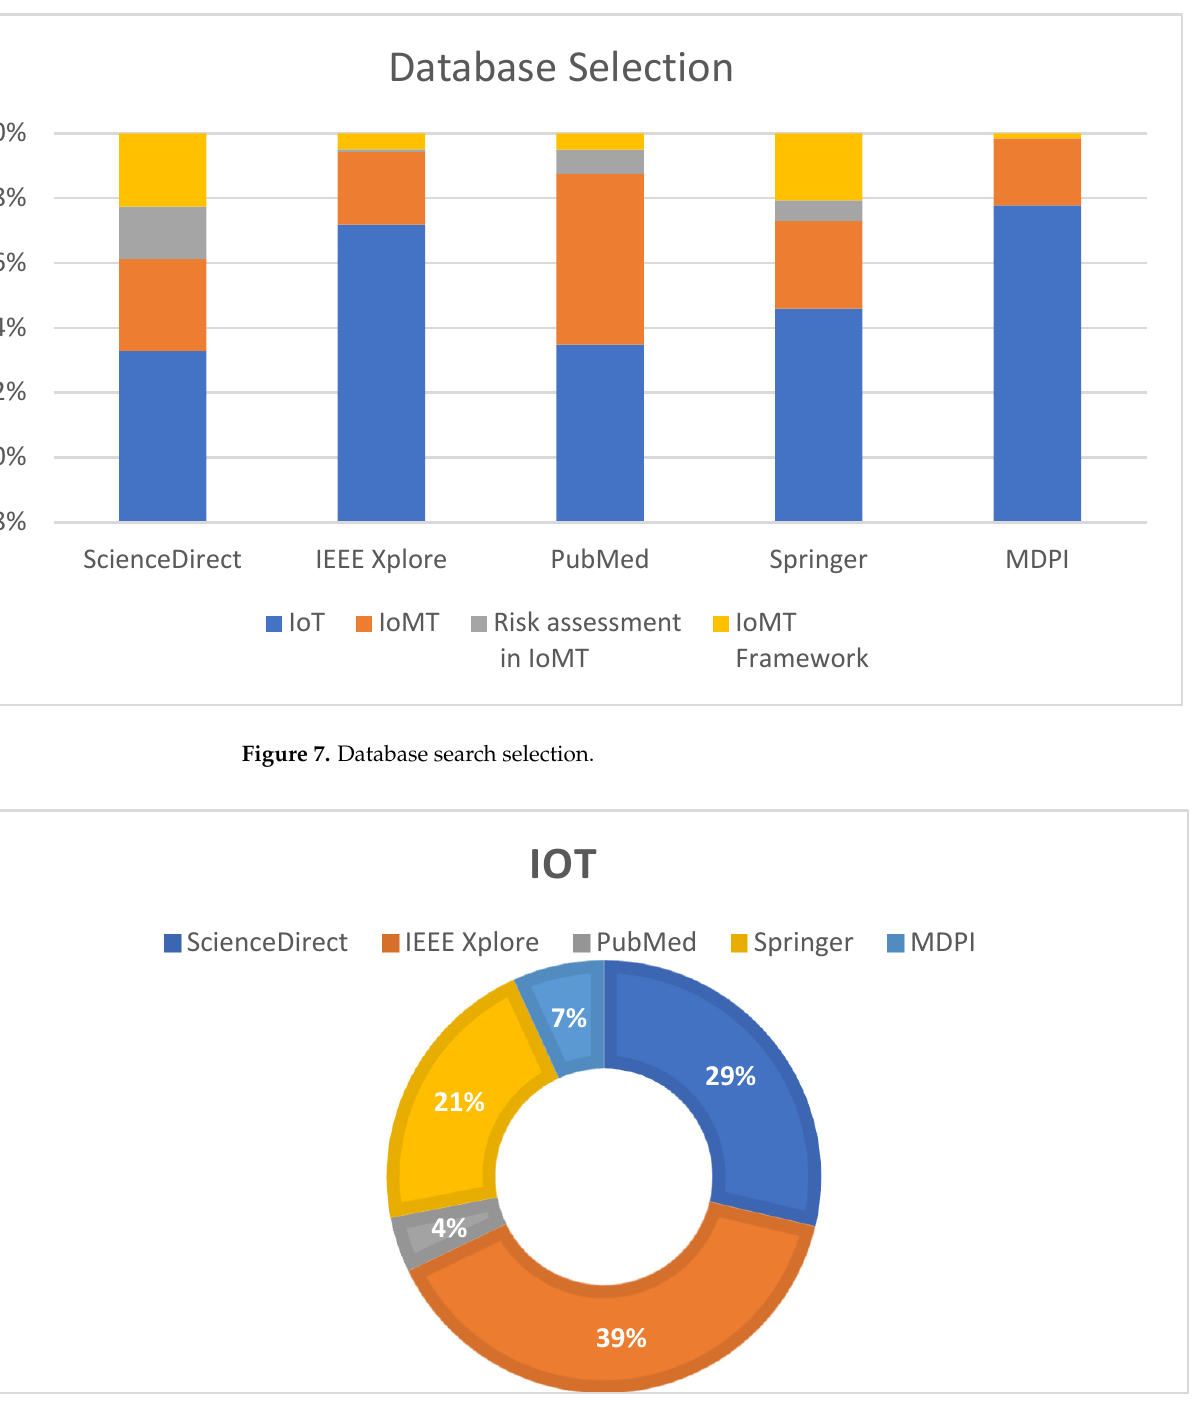
Figure 8. Search result for term IoT.